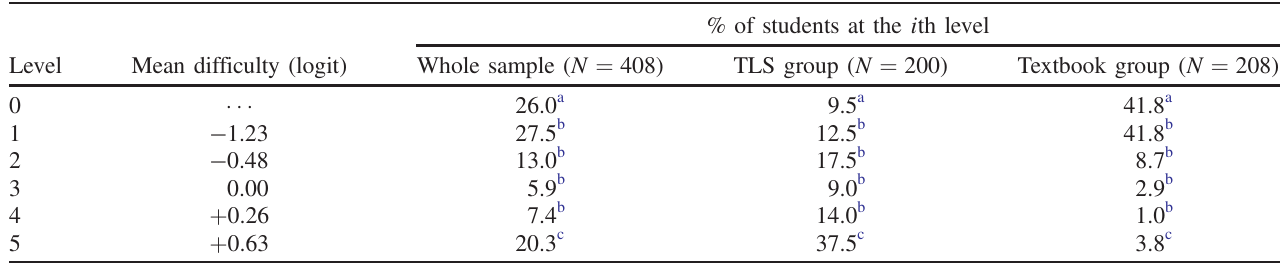
þ 0 . 63 a Students with ability lower than first level difficulty. b students with ability between i th and ( i þ 1 )th level difficulty. c students with ability greater than level 5 difficulty.